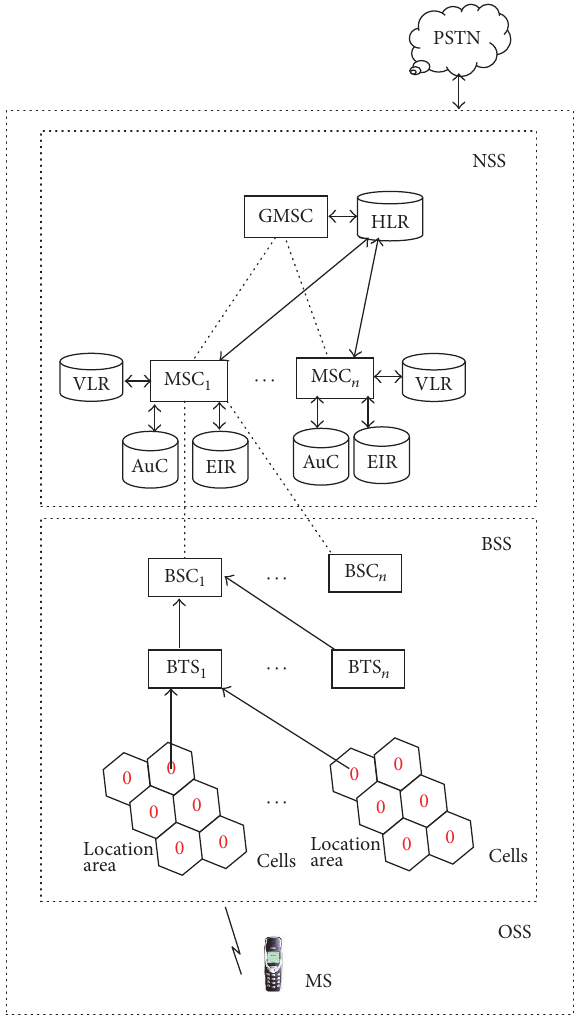
Figure 1: GSM network